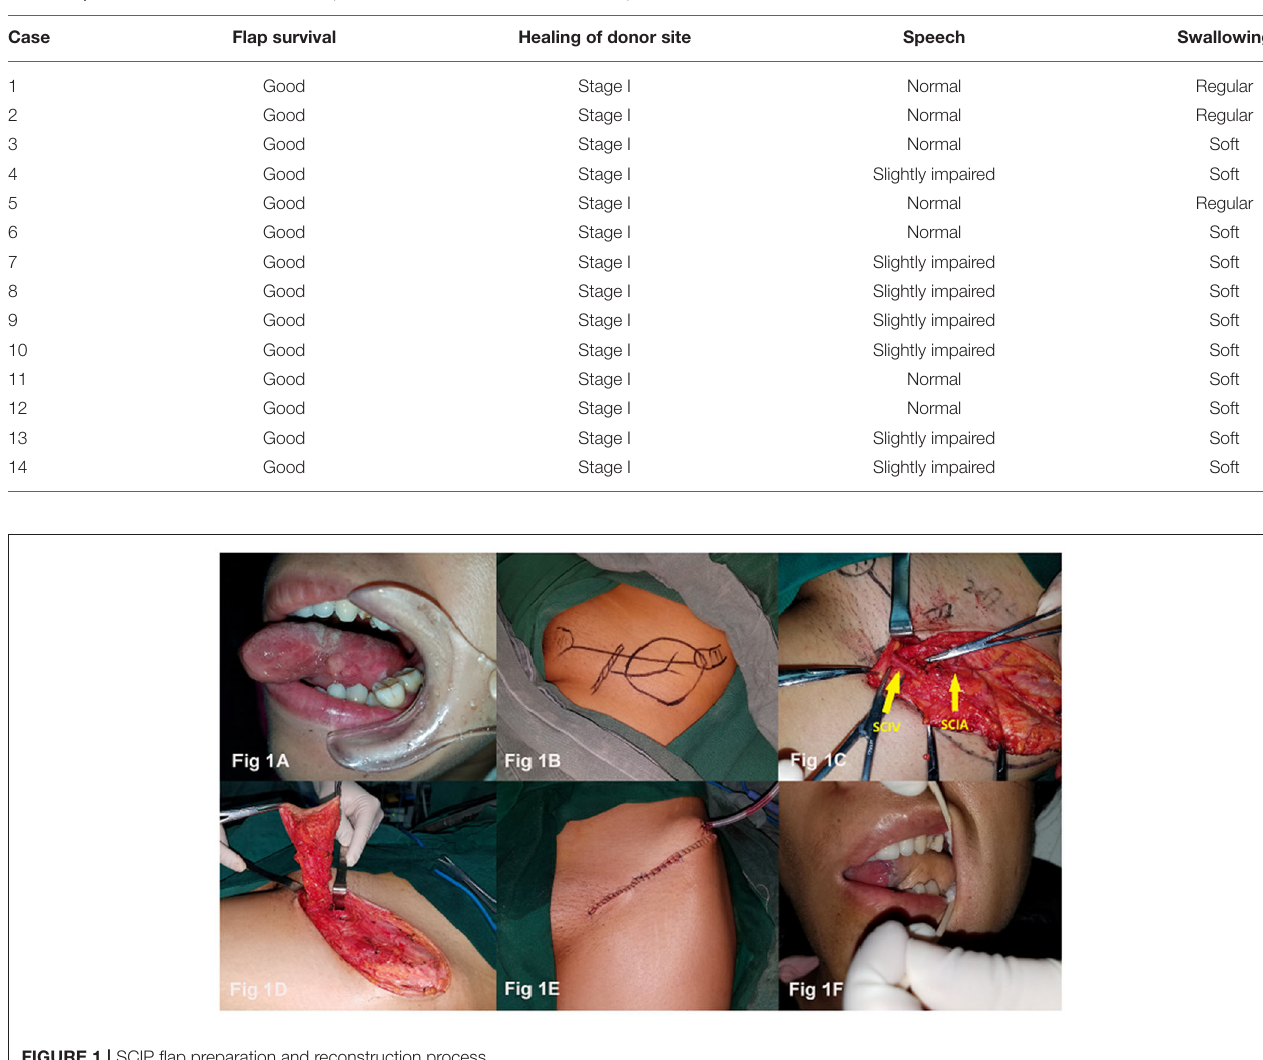
FIGURE 1 | SCIP flap preparation and reconstruction